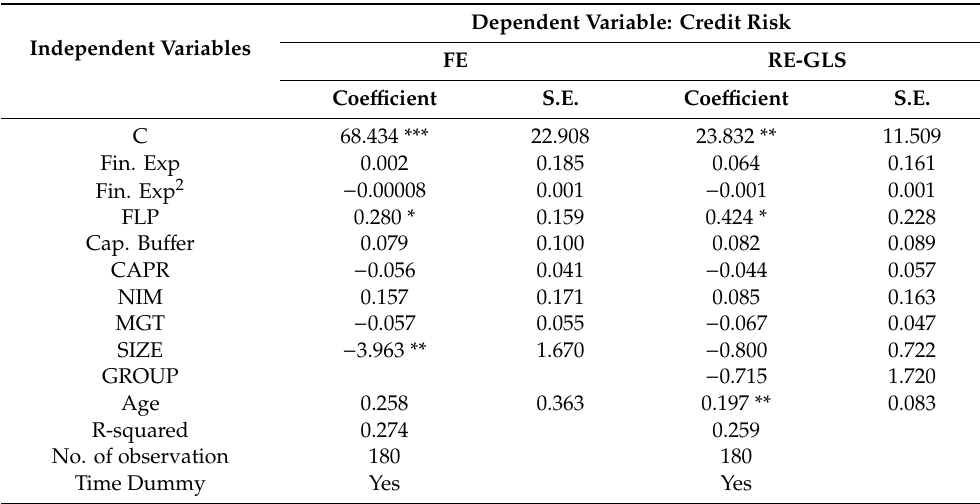
Table 7. Estimated Results for Model with Age